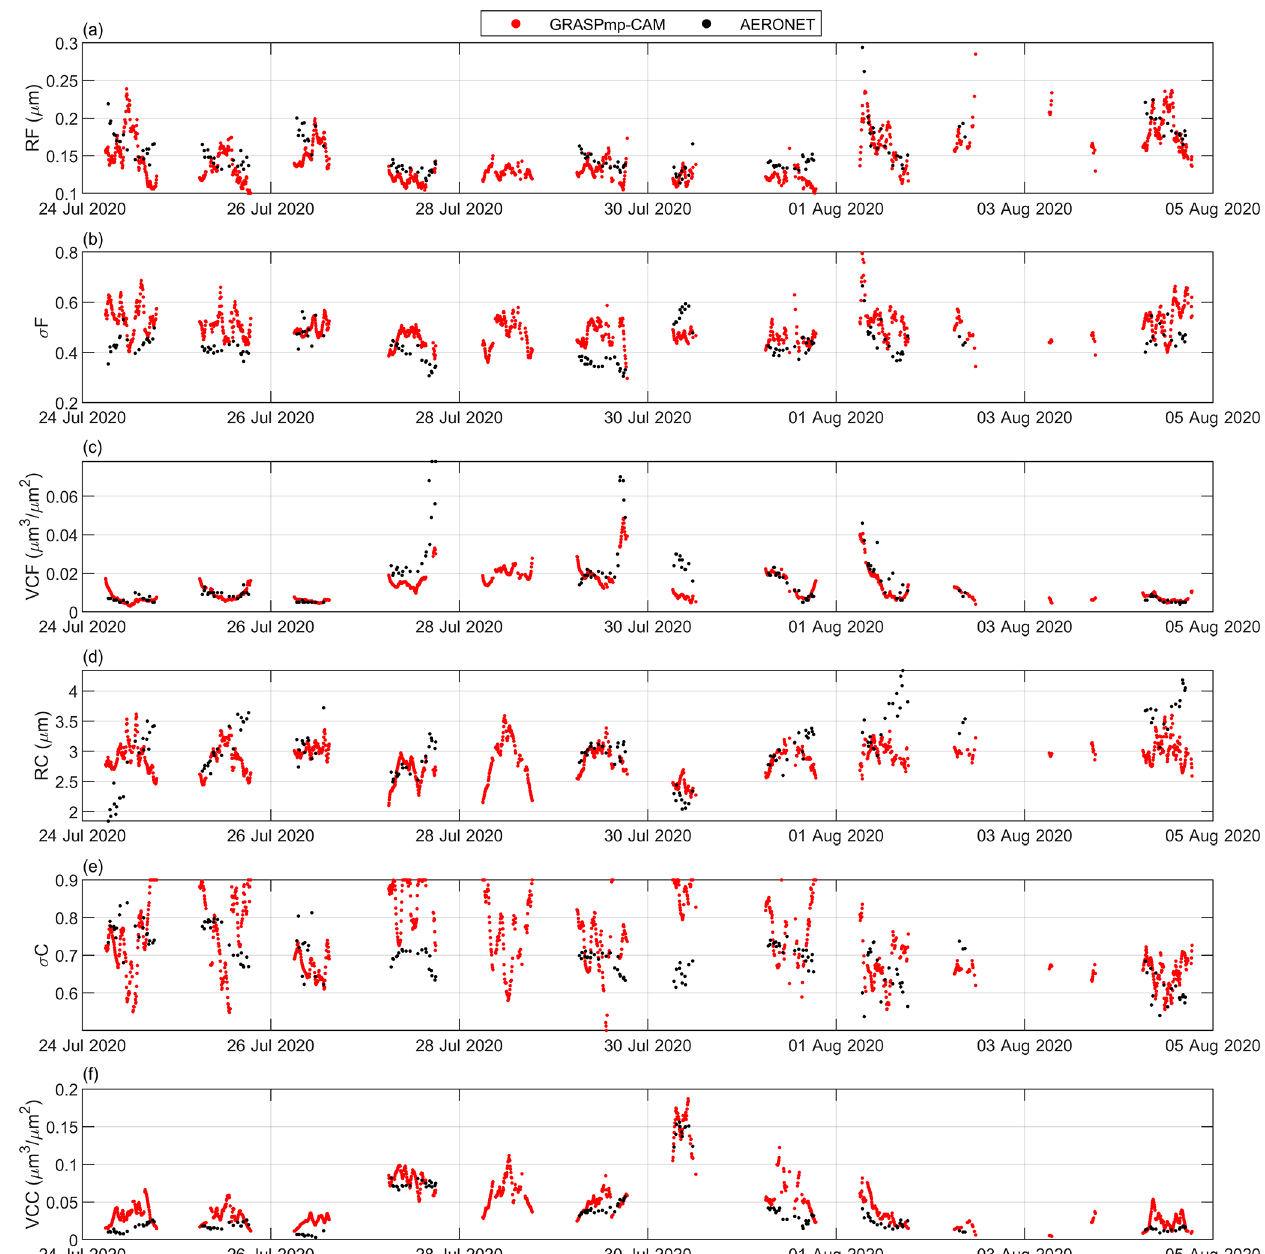
Figure 19. Volume median radius, R , standard deviation of log-normal distribution, σ , and aerosol volume concentration, VC, for fine (F; a–c ) and coarse (C; d–f ) modes retrieved by GRASP with the multi-pixel approach (GRASPmp-CAM) and by AERONET at Valladolid from 24 July to 4 August